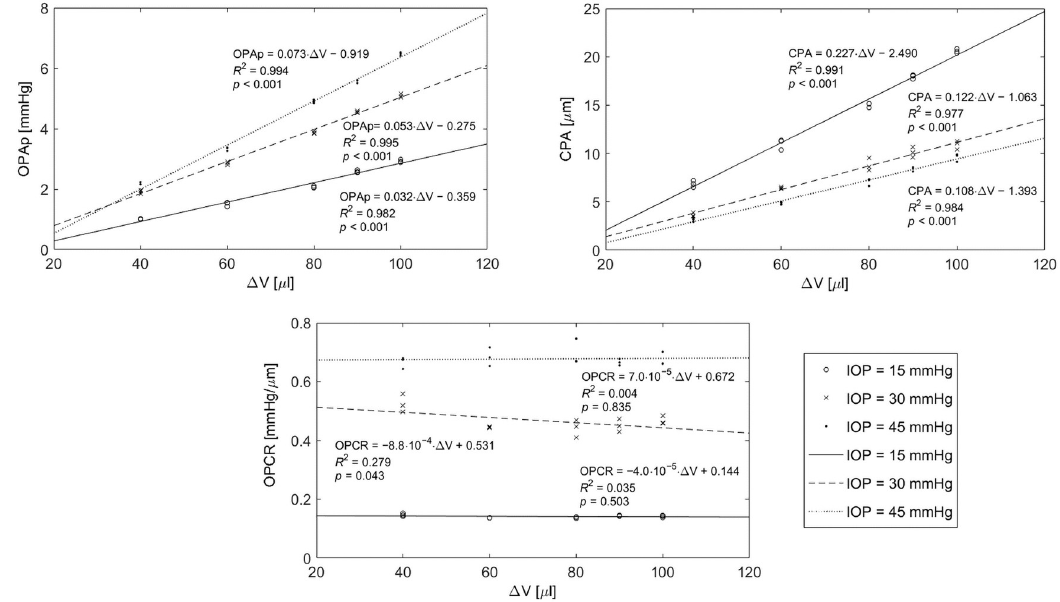
Fig 4. Regression analysis of physical ocular pulse amplitude (OPAp), corneal pulse amplitude (CPA), and ocular pulse based corneal rigidity index (OPCRI), with infusion/withdrawal volume Δ V, for three different IOP values.